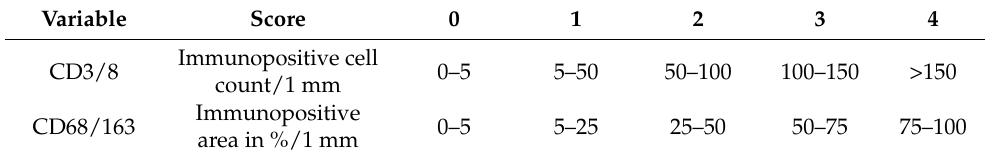
Table 3. Description of the semiquantitative scoring system for lymphocyte and macrophage markers. Variable Score